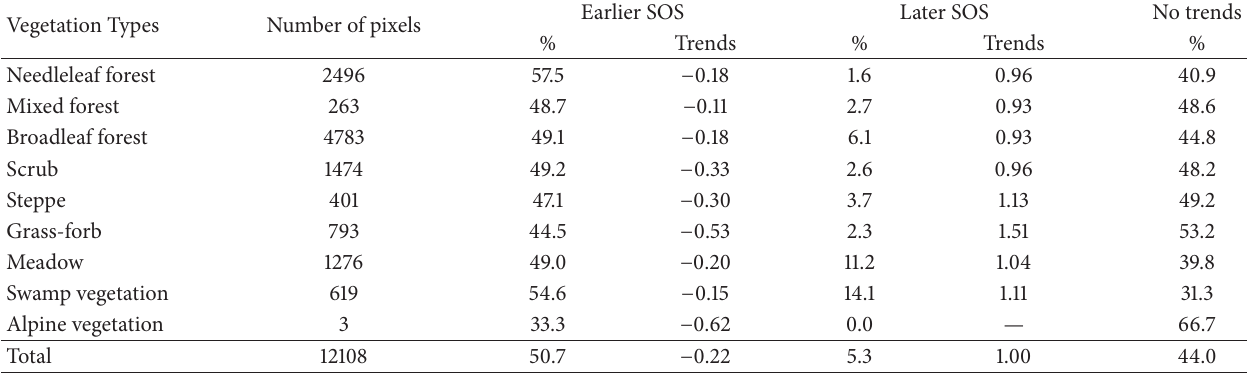
Table 5: The percentage of pixels with significant earlier or later SOS trends for each vegetation type.